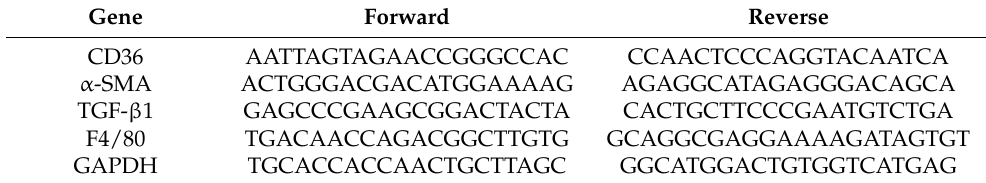
Table 2. Primer sequences for RT-qPCR.